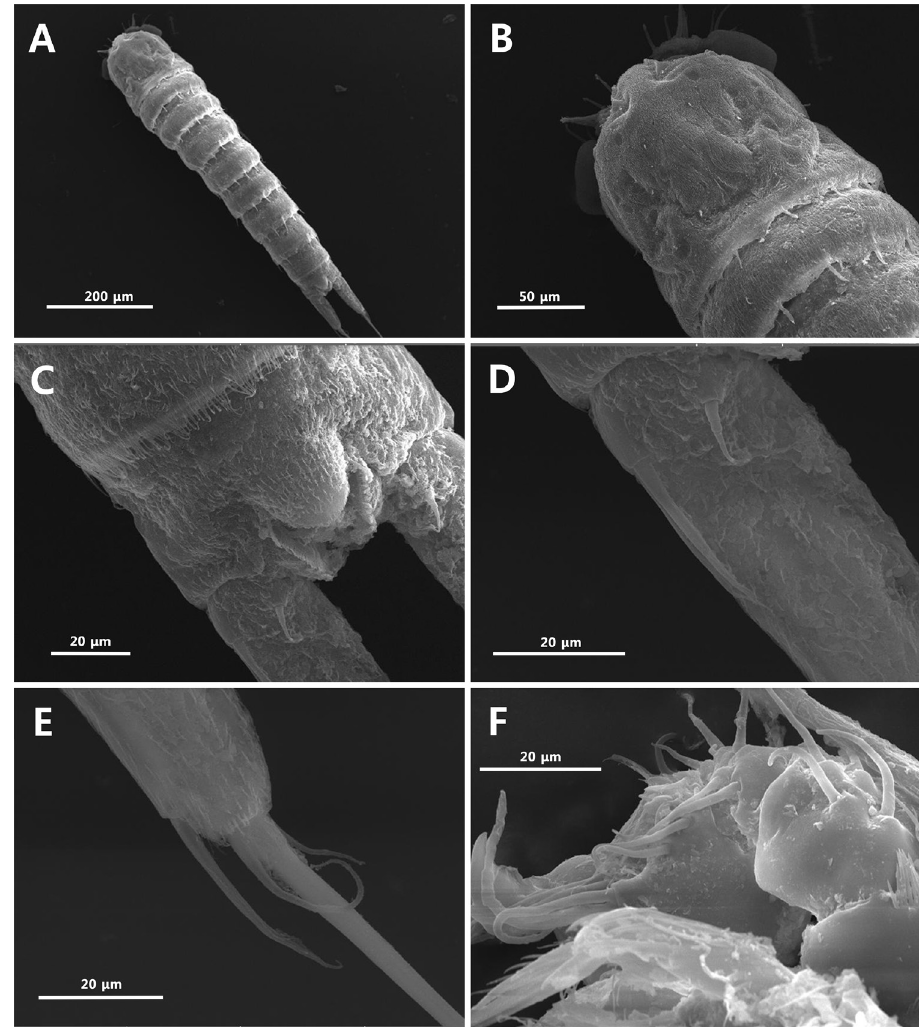
Figure 10. Scanning electron microscope photographs. Strongylacron glabrum sp. n. male: A habitus, dorsal B cephalothorax and thoracic somite 2, dorsal C anal somite, dorsal D proximal part of caudal ramus E distal part of caudal ramus, dorsal F antennule,